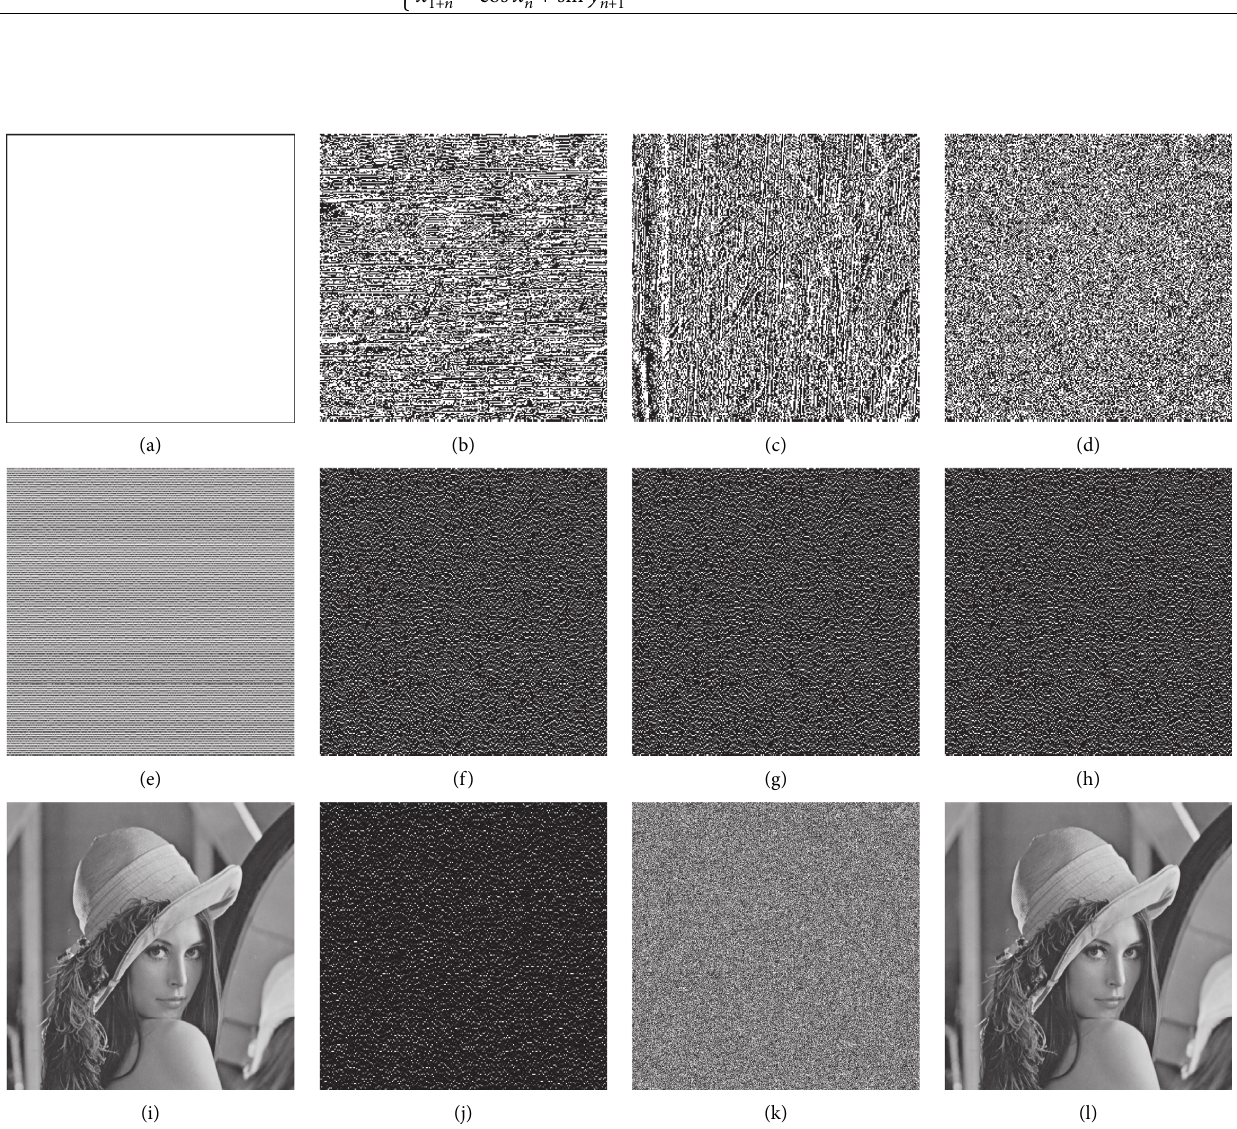
Figure 12: The simulation steps: (a) LL component; (b) LH component; (c) HL component; (d) HH component; (e) LL component confusion; (f) LH component confusion; (g) HL component confusion; (h) HH component confusion; (i) original image; (j) overall confusion; (k) encrypted image; and (l) decrypted